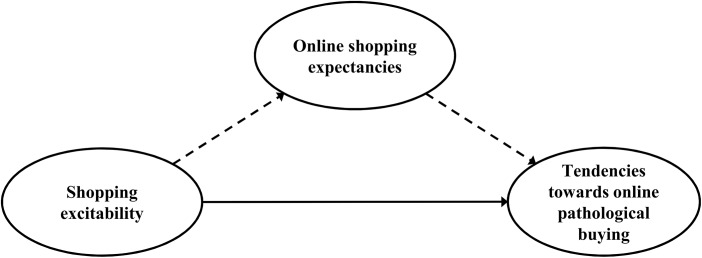
Illustration of the proposed mediation model.The tendencies towards online pathological buying are assumed to be predicted by the predisposing factor shopping excitability (operationalized by variables of cue-reactivity) and online shopping expectancies (operationalized by motives to shop and buy on the Internet). The expectancies should mediate the relationship between shopping excitability and tendencies towards online pathological buying. The direct effect is indicated by the continued arrow; the indirect effects are drawn dashed.